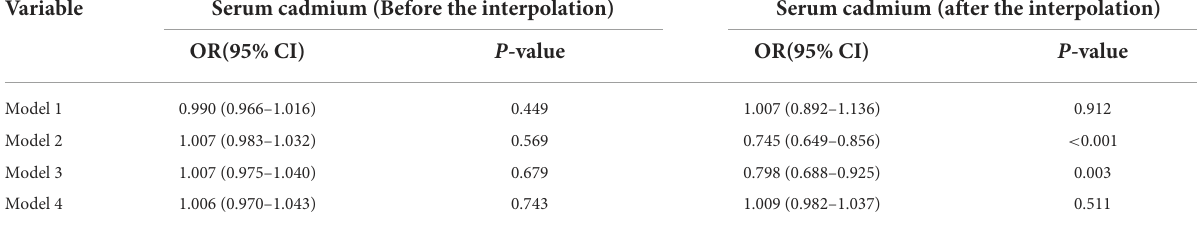
TABLE 5 ORs (95%CIs) of the association between serum cadmium levels and diabetes in the high cadmium exposure group. ORs (95%CIs) in the high cadmium exposure group Variable Serum cadmium (Before the interpolation) Serum cadmium (after the